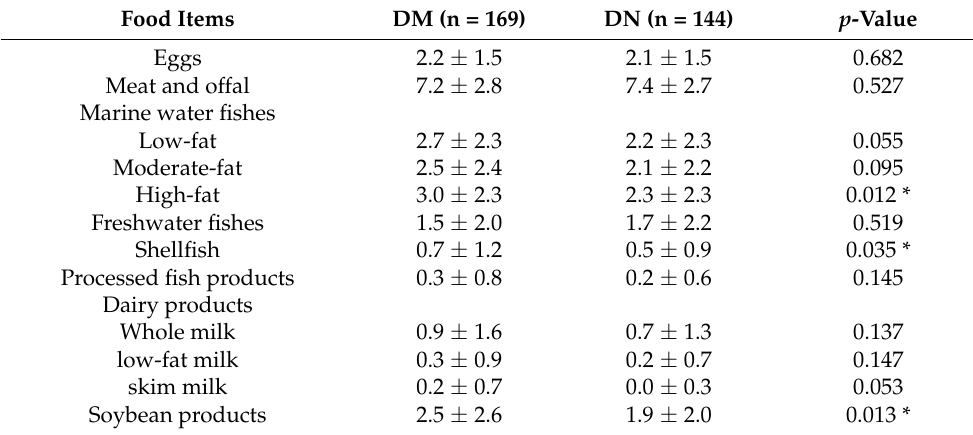
Table 2. Weekly consumption (no. of servings/week) of selected foods by DM and DN groups as assessed through a semiquantitative food frequency questionnaire.